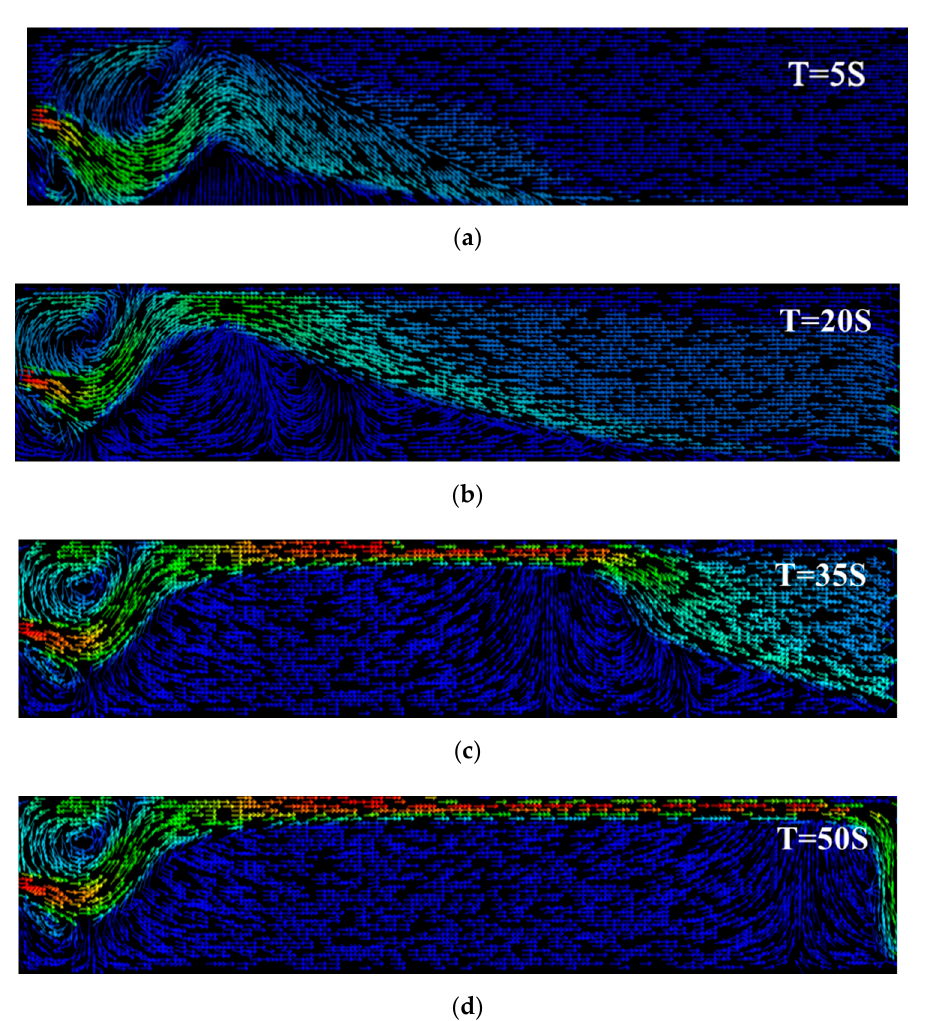
Figure 7. Four stages for proppant transport under high Reynolds number condition. ( a ): initial settlement Stage; ( b ) vertically grow Stage; ( c ) horizontally grow Stage; ( d ) equilibrium State